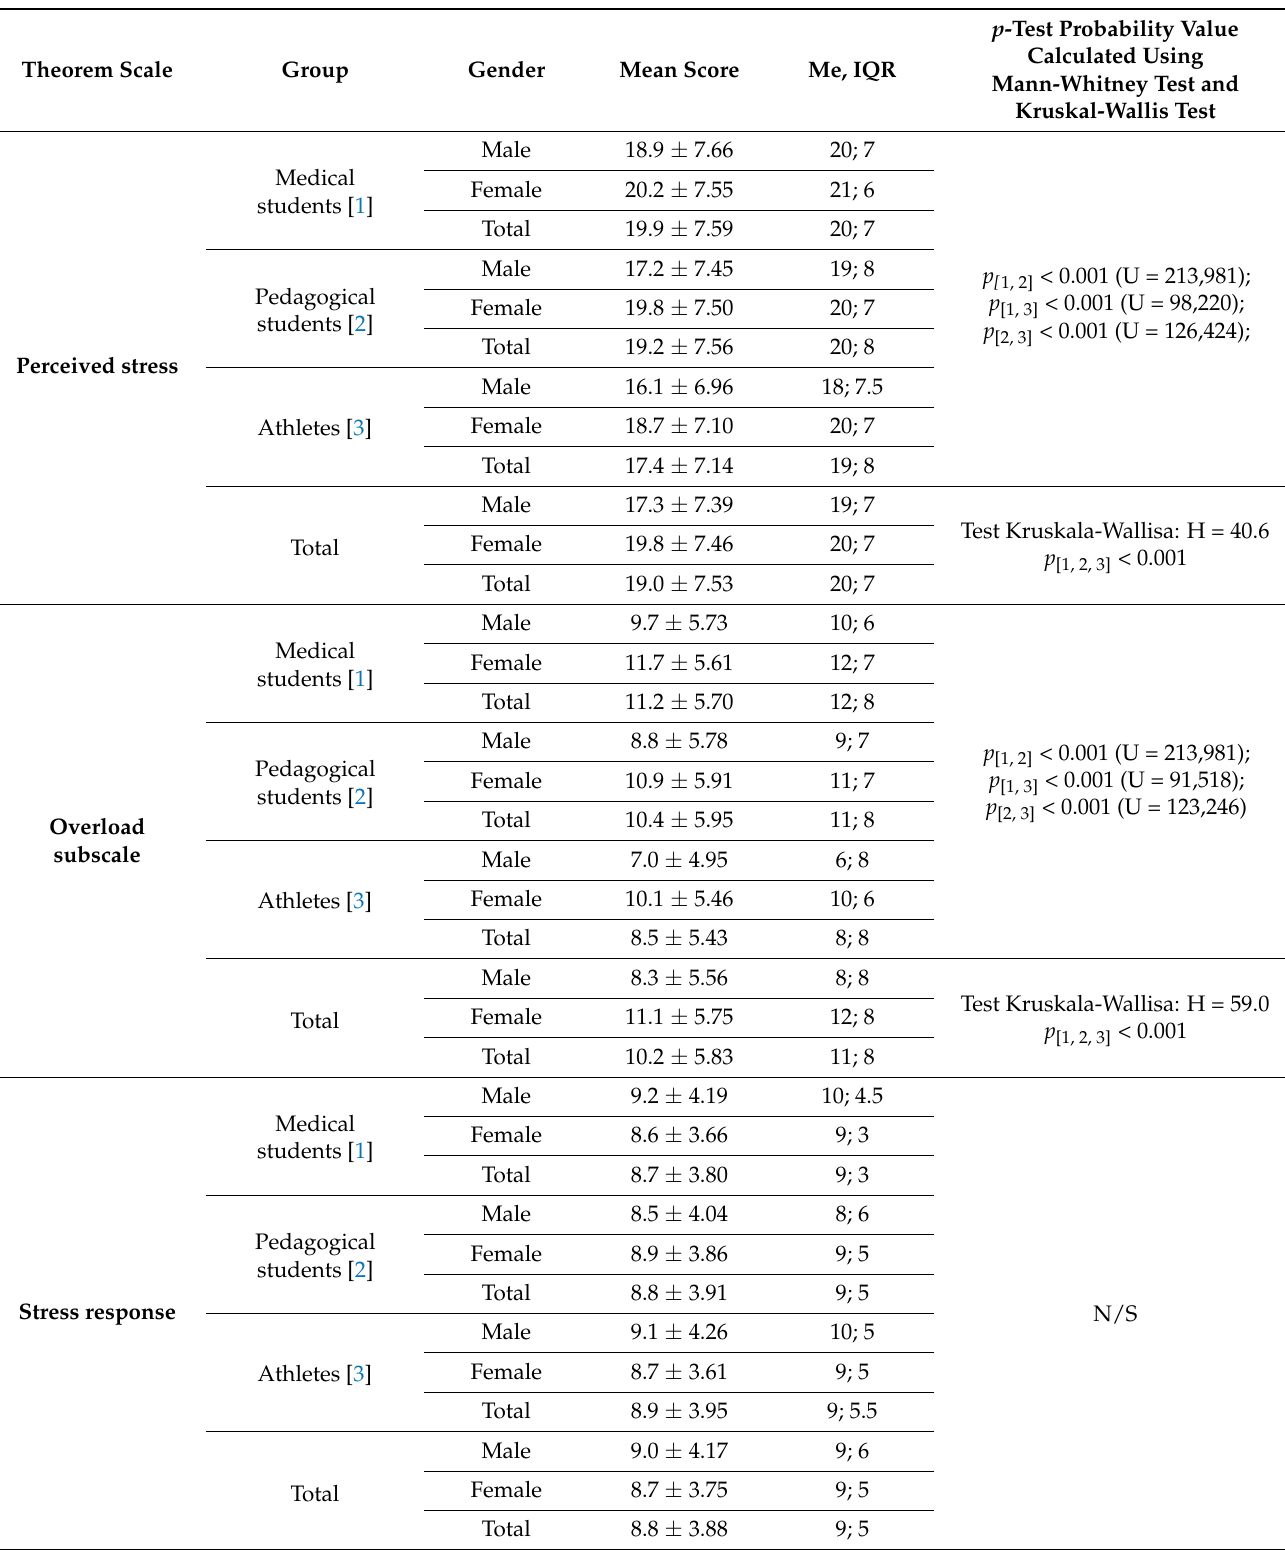
Table 5. Summary of the data describing the differences in the scores obtained by students of both genders in the three groups on the Perceived Stress Scale and its